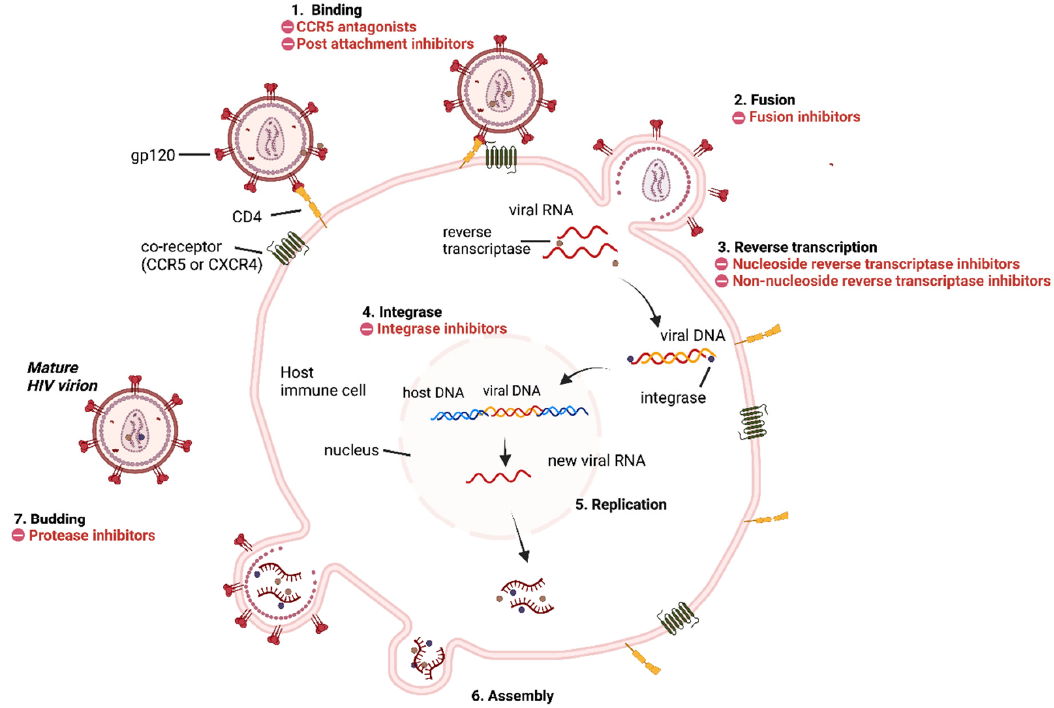
Figure 2. Simplified representation of the HIV life cycle mapping the types of inhibitors that can interrupt viral entry and replication.